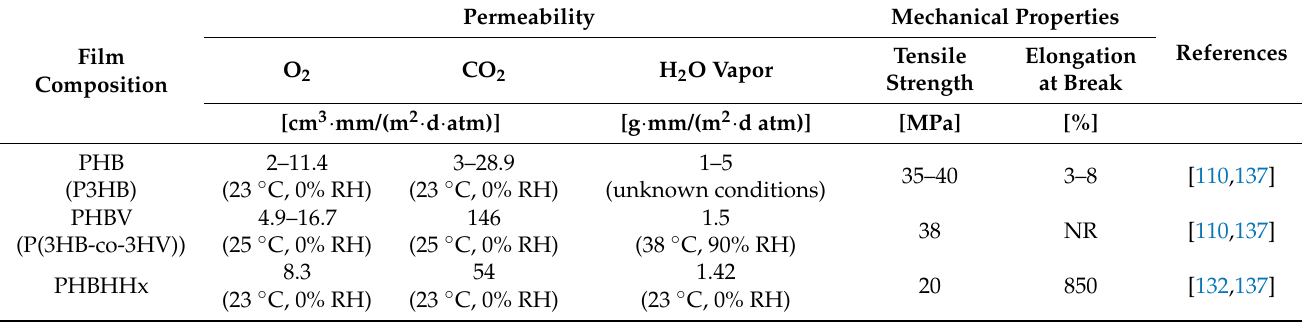
Table 2. Barrier and mechanical properties of bio-based polymers produced by microorganisms.